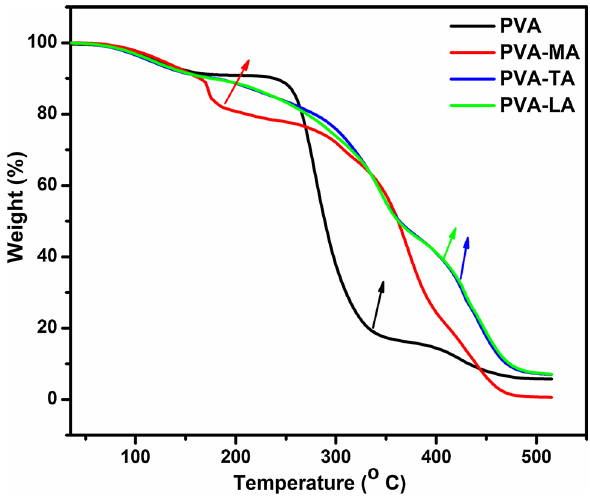
Fig. 7 TGA curves for a PVA, b PVA/MA, c PVA/TA, and d PVA/ LA films